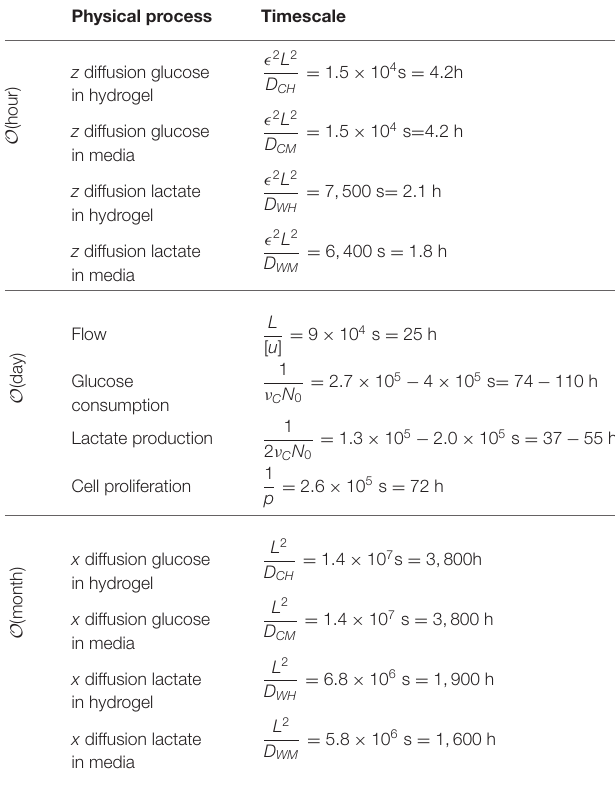
TABLE 2 | Timescale groupings of the various physical processes present in the CXP1 bioreactor. Physical process